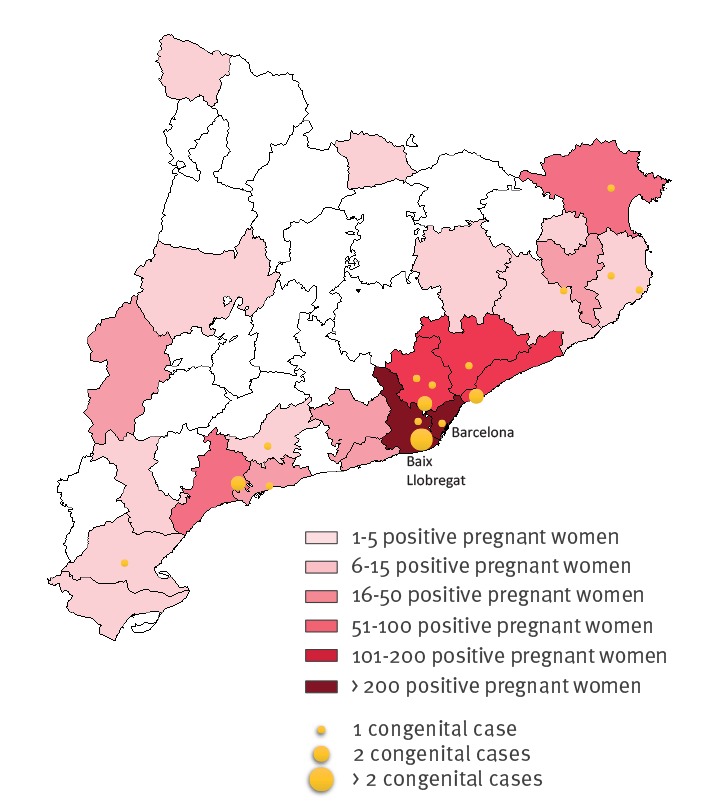
Geographical distribution of Trypanosoma cruzi-positive pregnant women and cases of congenital transmission, Catalonia, 2010–2015 (n = 818)